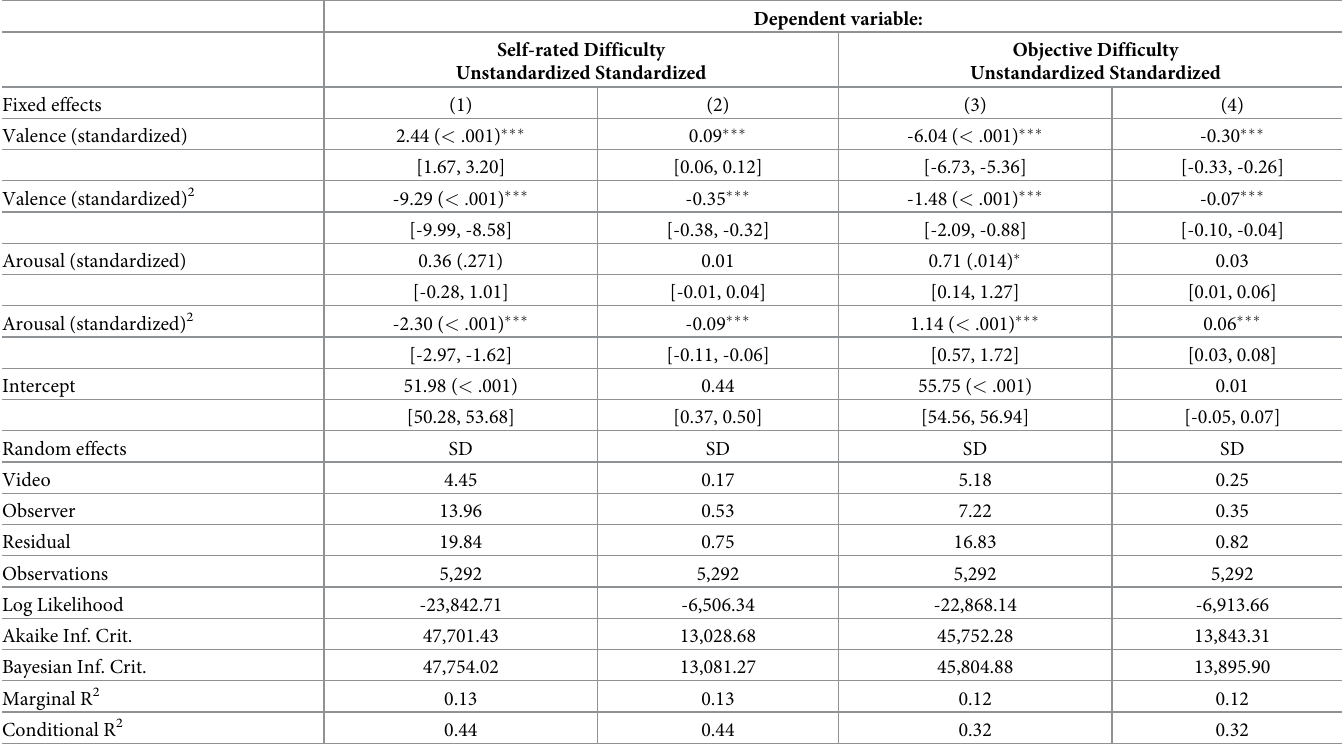
Table 3. Mixed effects models for self-rated and objective difficulty predicted by valence and arousal ratings and random effects for video and observer. Exact p val- ues are shown in the brackets next to the unstandardized estimates. 95% Confidence Intervals are shown in square